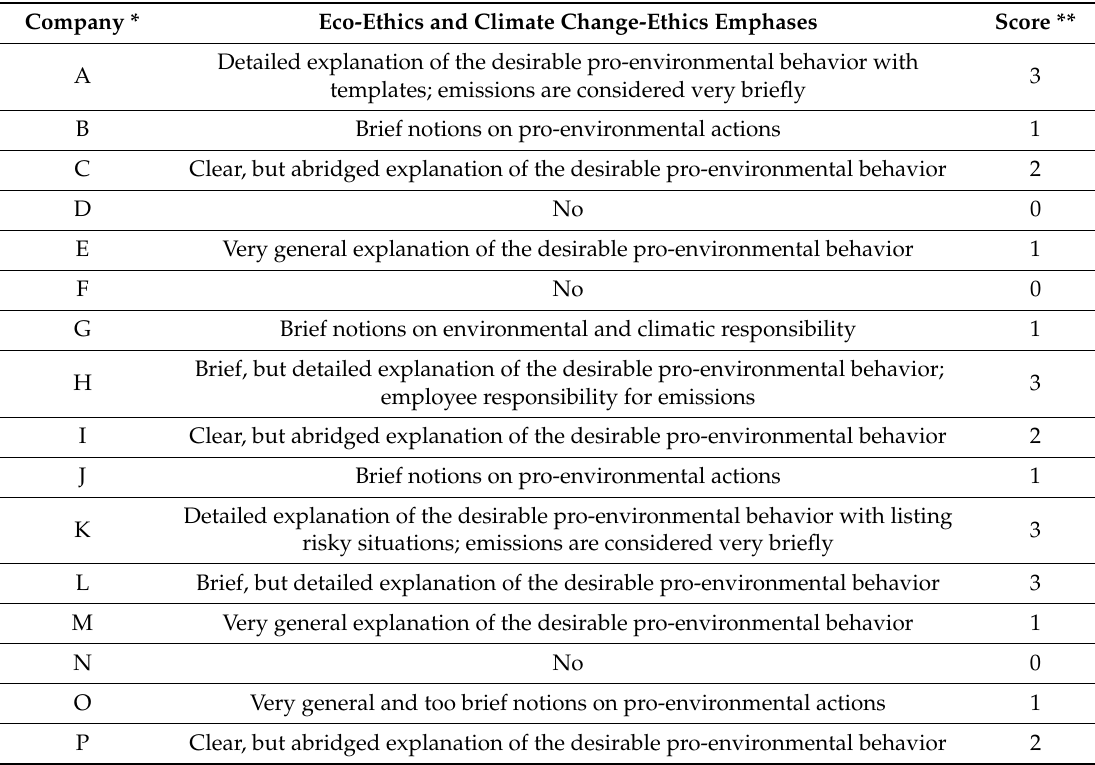
Table 4. Attention to pro-environmental and climate-friendly behavior in the codes of conduct of the considered airline